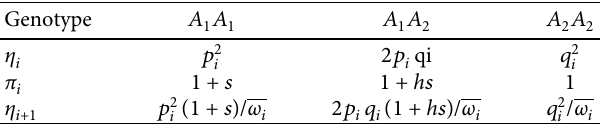
and A in a sexual population at a 1 2